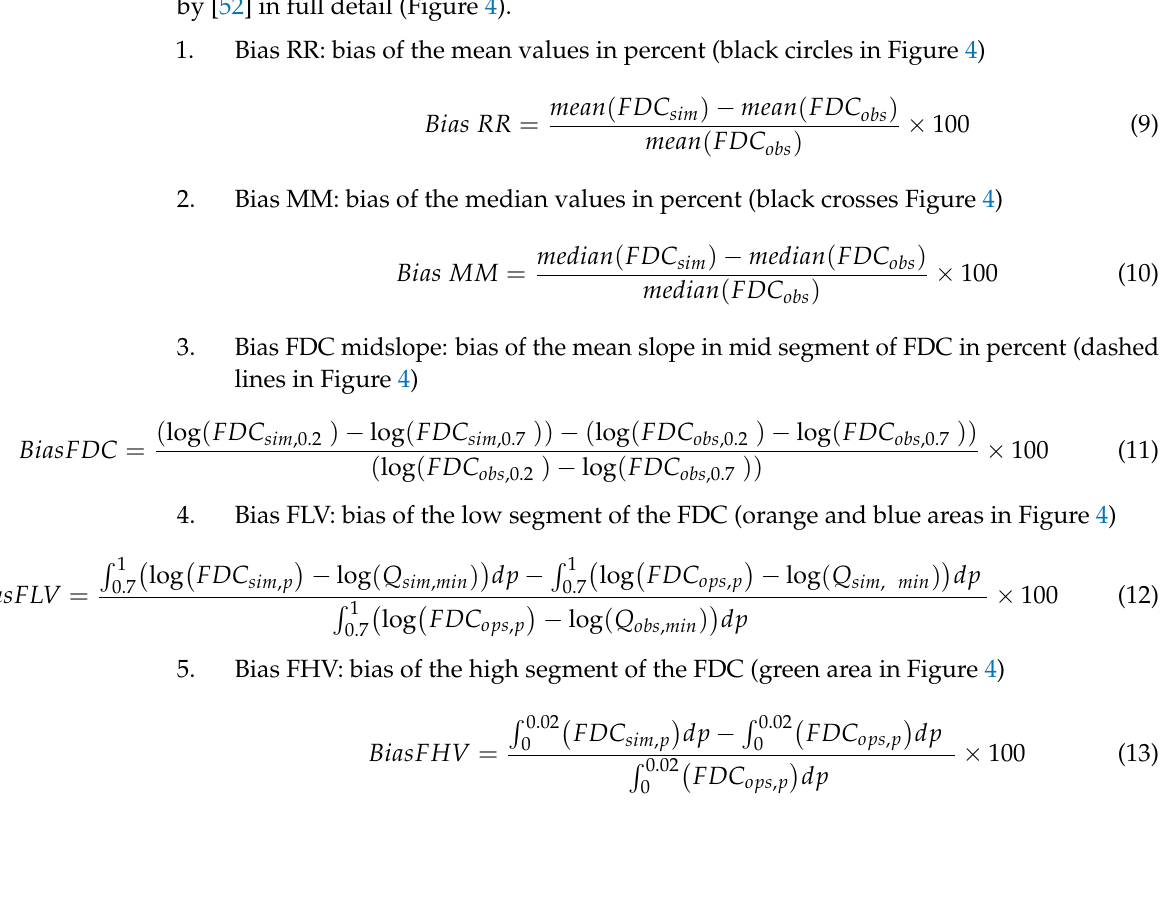
1. Bias RR: bias of the mean values in percent (black circles in Figure 4)